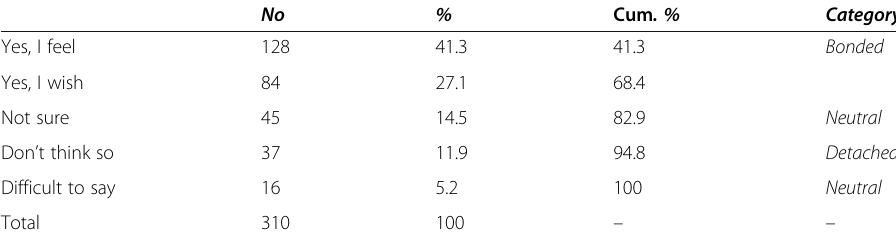
Table 4 Feelings of membership in relation to the shipping company